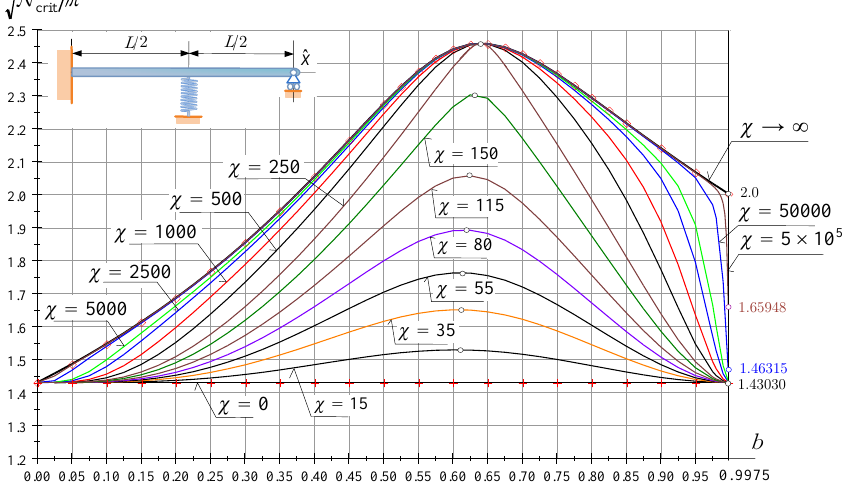
Figure 9 depicts the dimensionless critical force against b . χ is a parameter. If χ = 0 the beam is a fixed-pinned beam for which critical for reaches its maximum if b ∈ [ 0.62, 0.645 ] .